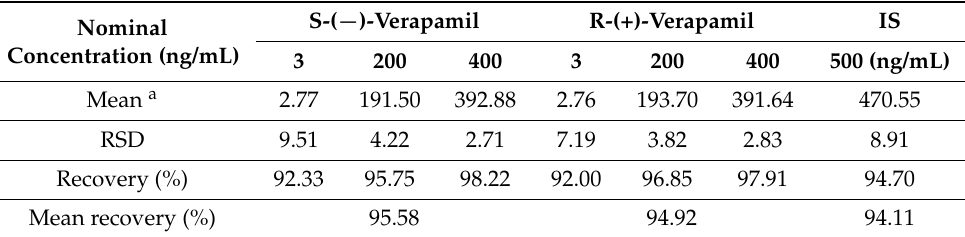
Table 5. Extraction recovery for the analysis of S-( − )- and R-(+)-verapamil and IS in rat plasma by the proposed method.